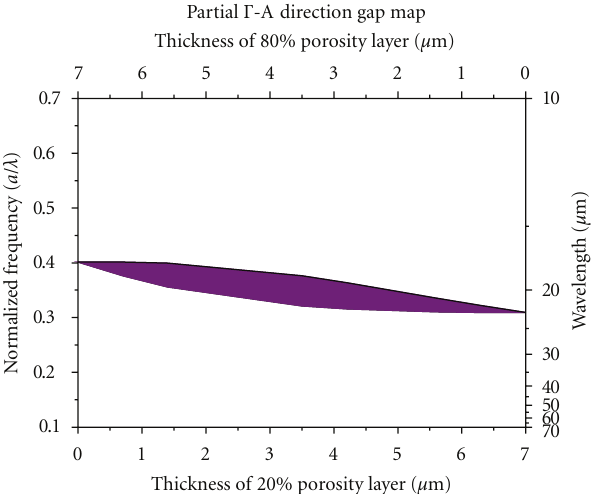
Figure 8: Partial Γ -A gap map as a function of the thickness of the di ff erent PSi layers. The lattice parameter used was a = 7 μ m, as the experimental one (see Section